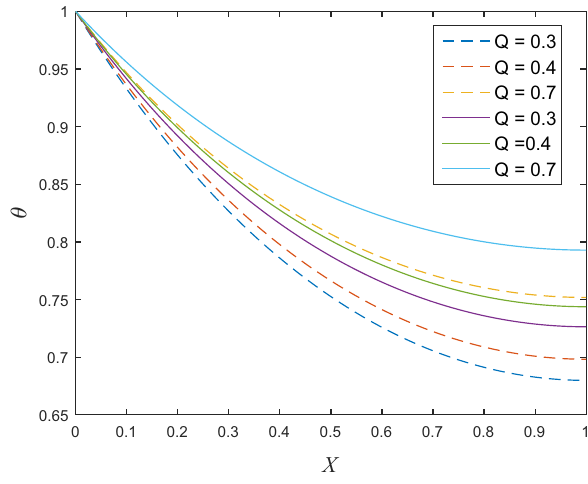
Figure 8: E ff ect of Q (- - linear variation and — non - linear variation ) on the temperature distribution of the fi